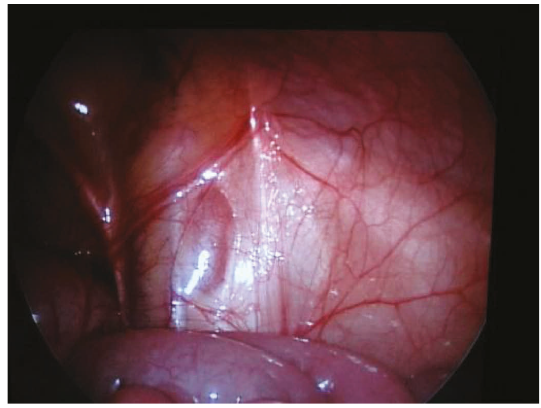
Figure 1: Laparoscopic image of right vanishing testis.